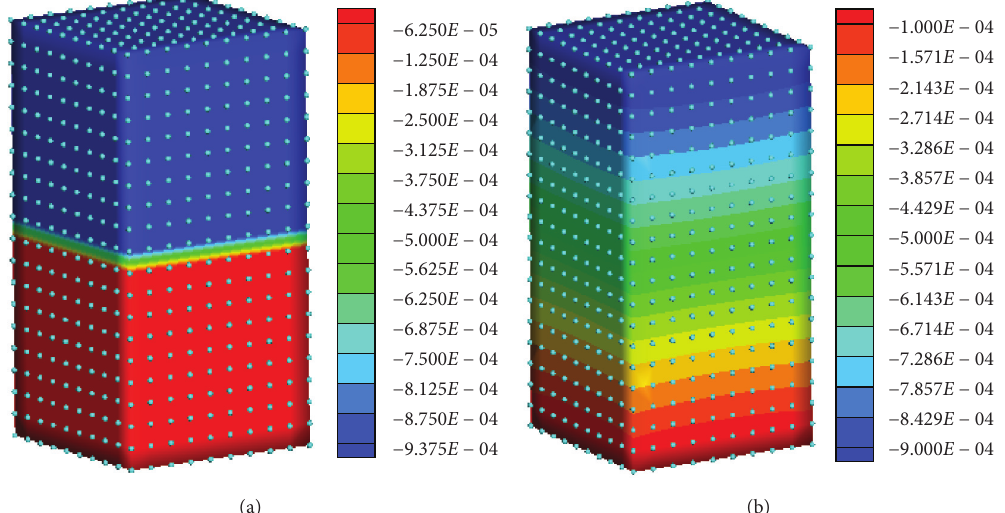
Figure 5: Vertical displacement nephogram